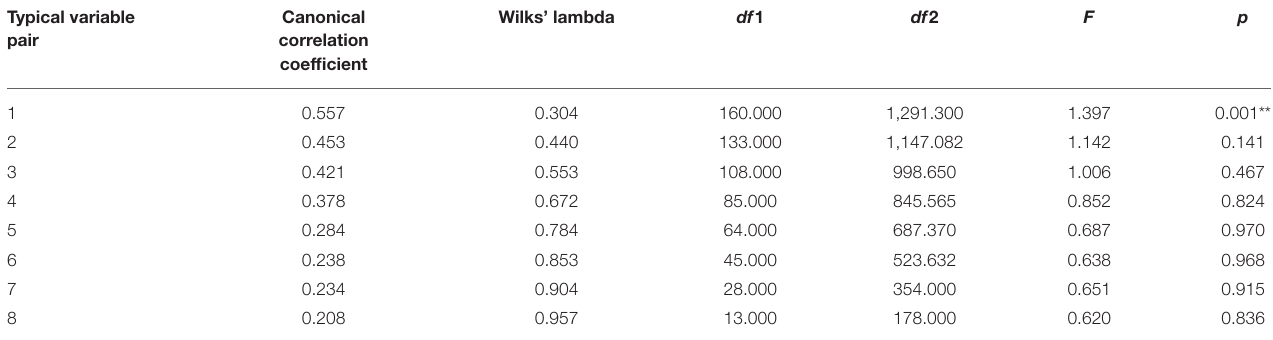
TABLE 4 | Typical correlation coefficients and significance between motor performance and motor behavior. Typical variable pair